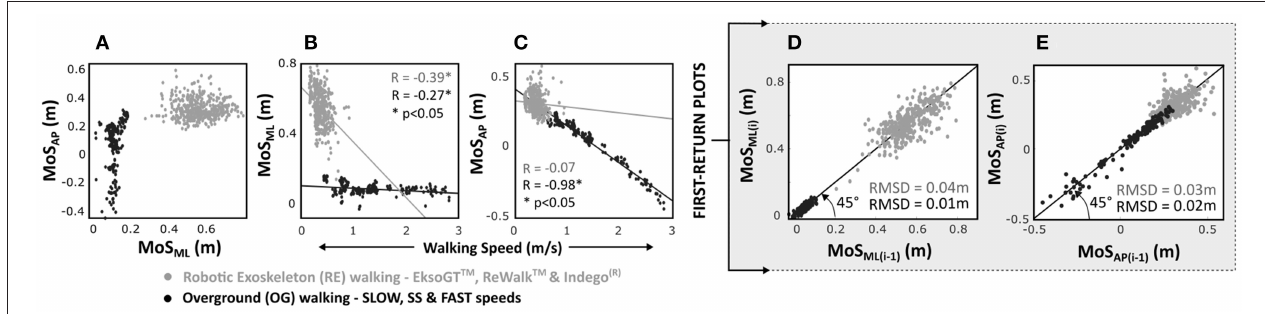
FIGURE 2 | MoS outcomes in anterior–posterior (AP) and medial–lateral (ML) directions grouped by overground (OG) and robotic exoskeleton (RE) walking for able-bodied individuals at heel-strike. Correlations for (A) MoS AP vs. MoS ML , (B) MoS ML , and (C) MoS AP vs. walking speed and first-return plots for (D) MoS ML and (E) MoS AP .